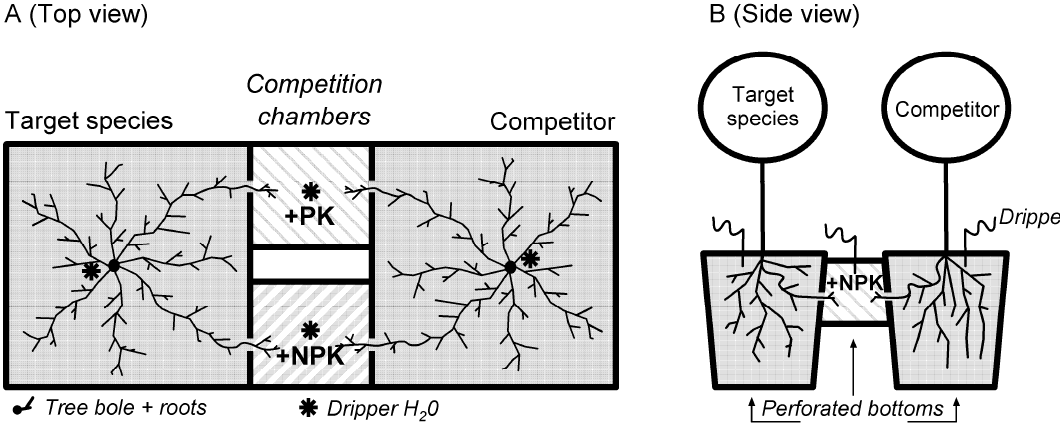
Figure 1. Microcosm system to study competition for localized nutrient-rich soil patches (i.e., competition chambers (CC) with NPK fertilization); ( A ) top view, ( B ) side view. Five-cm long sections of target (focal) species and competitor species’ fine roots were inserted from opposite sides into the CC (in intra- and interspecific competition treatments); in the isolation (no competition) treatment, the apertures between the competitor and both CC were closed from one side (not displayed). Positions of tree boles (in microcosms with nutrient-poor substrate) and drippers are displayed. Nutrient-rich fertilizer ( + NPK) was applied to the CC only; CC fertilized with a nutrient solution lacking nitrogen ( + PK) are not part of this manuscript to keep manageable length and focus. Drawings not at scale.